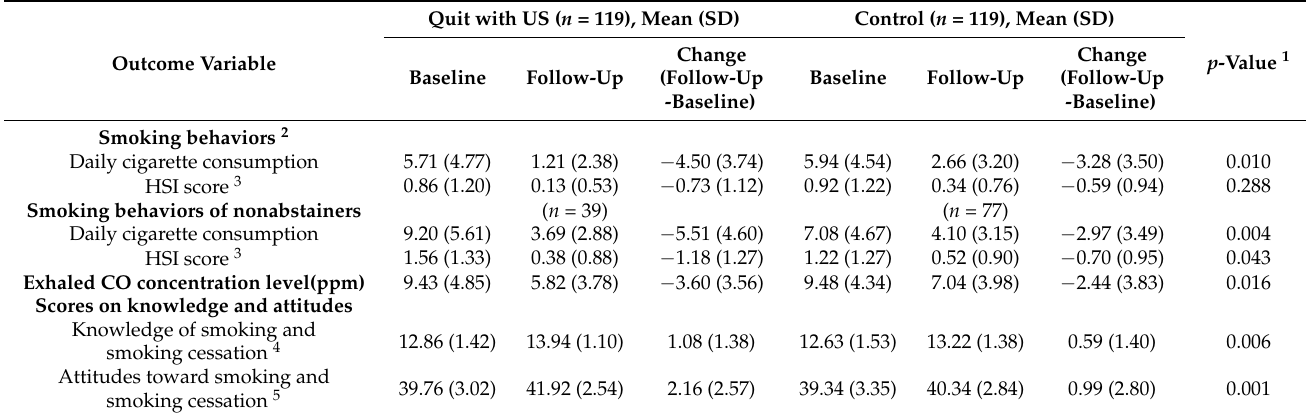
Table 3. Secondary outcomes in the Quit with US